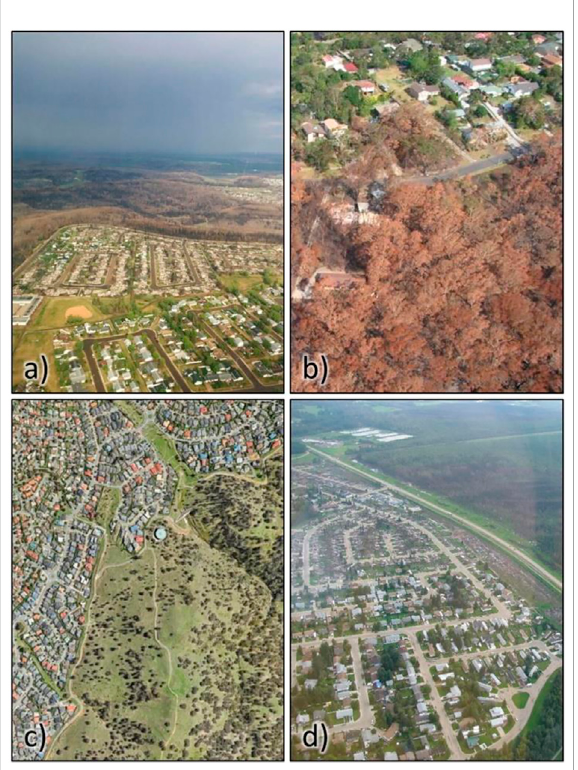
FIGURE 2 Examples of the wildland-urban interface across the world (Johnston et al., 2019) (Examples of interface WUI in (A) Fort McMurray,Alberta, Canada (Canadian Forest Service/Wiens B.); (B) Sydney, Australia (CSIRO/McArthur N.); (C) Australia (Google Maps); and (D) Slave Lake, Alberta, Canada (University of Alberta/ Flannigan M.)). The copyright of this fi gure is owned by the third party.